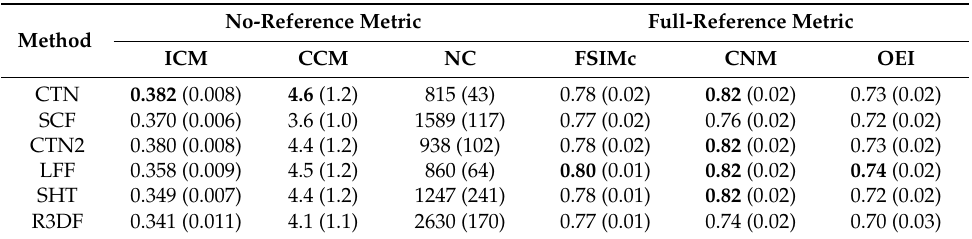
Table 1. Results of the computational image quality metrics (with their standard error) for each of the color fusion methods investigated in this study. Overall highest values are printed in